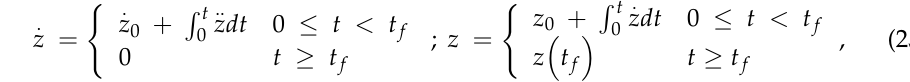
and Table 6. Parameters of the electro-mechanical section of the model.